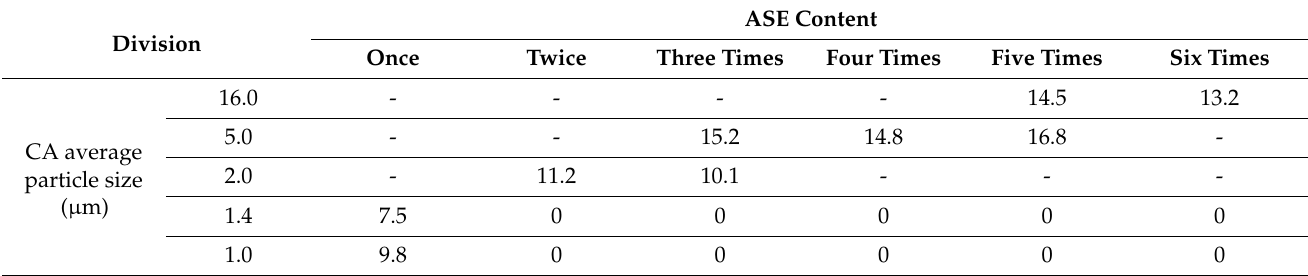
Table 8. The 40 ◦ C oil leakage stability test results